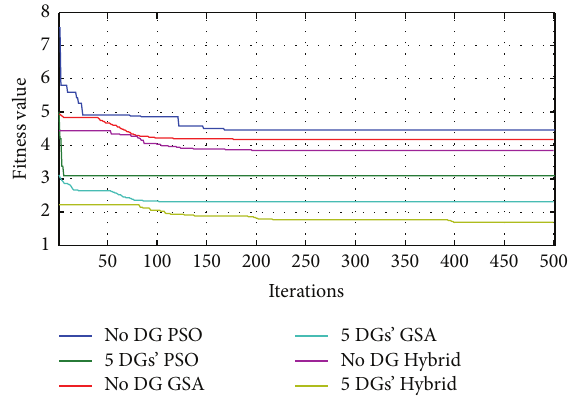
Figure 6: Comparison of no DG case with 5 DGs under LSF in 𝑃